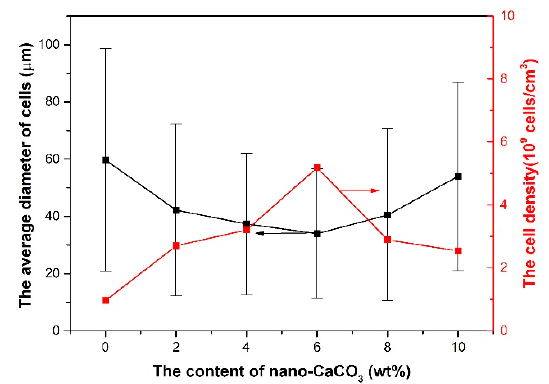
Figure 12. The average cell diameter and cell density of the core layer of the vertical sections with different contents of nano ‐ CaCO 3 .